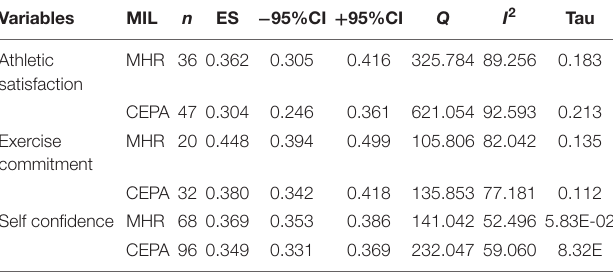
TABLE 5 | Effects of self-management on psychological outcomes based on level of sports participation.